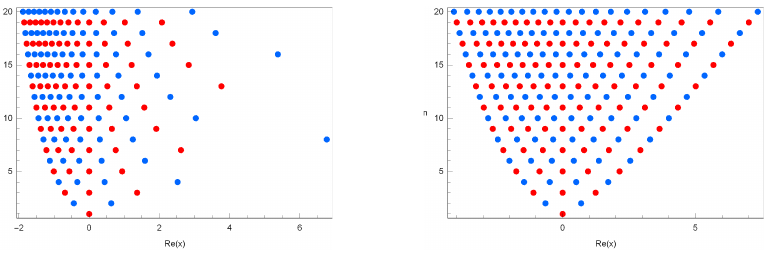
Figure 4. Stacks of zeros of H n , q ( x ) ,1 ≤ n ≤